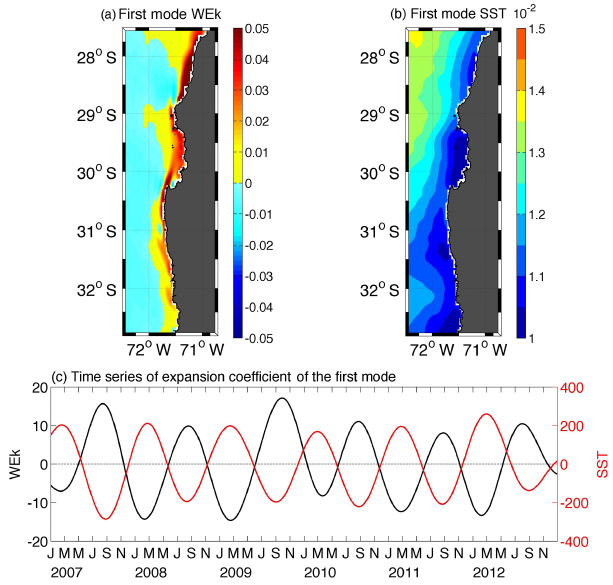
Figure 11. First SVD mode between Ekman pumping (WEk) from the WRF simulation at 4km resolution and sea surface temperature (SST) from MUR data. (a) The Ekman pumping spatial compo- nent. (b) The SST spatial component. (c) The black (red) line rep- resents the associated Ekman pumping (SST) time series. Note that the units are